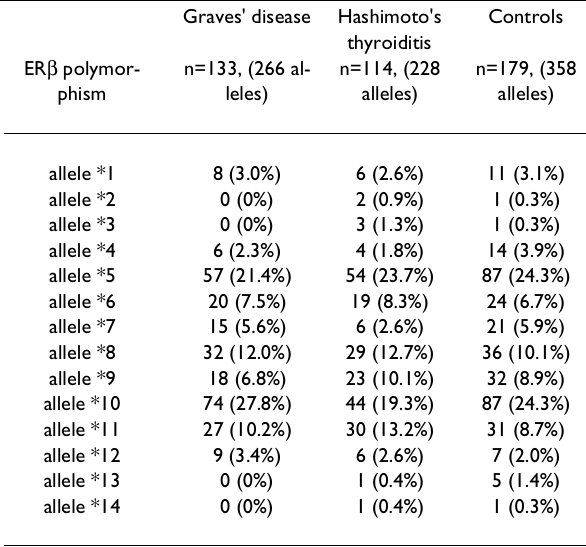
Table 1: Allele frequencies of the ER β gene polymorphism in pa- tients with AITDs and in control subjects Graves'